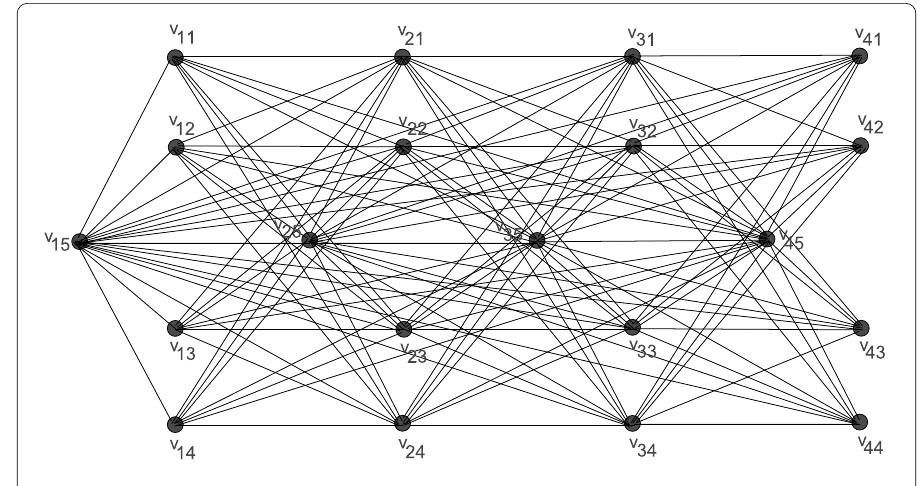
Figure 2 The co-normal product graph of P 4 and S